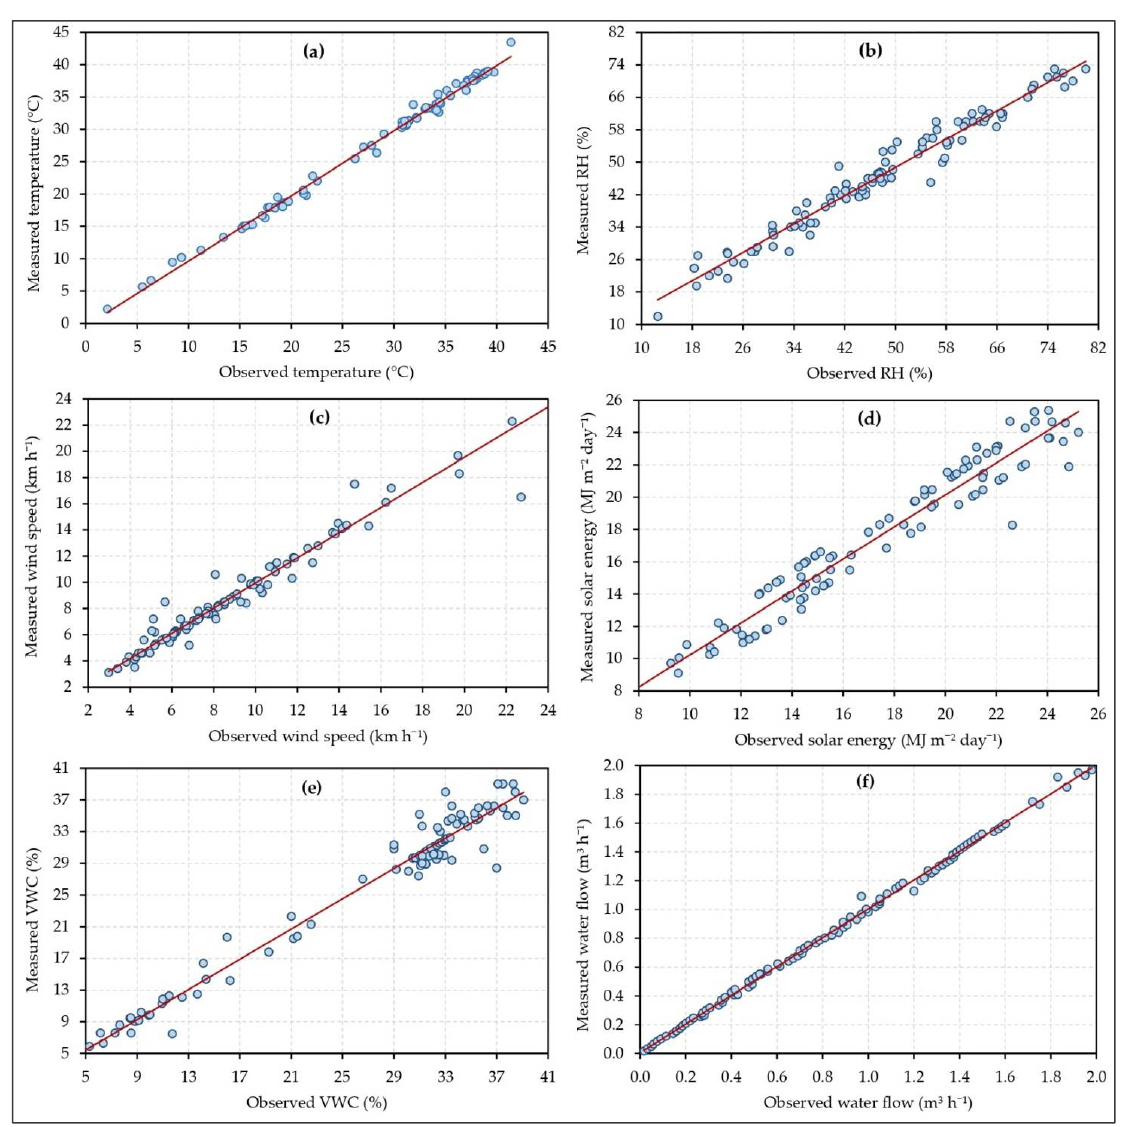
Figure 8. The sensors’ calibration curves of temperature ( a ), relative humidity ( b ), wind speed ( c ), solar energy ( d ), volumetric water content ( e ), and water flow rate ( f ).